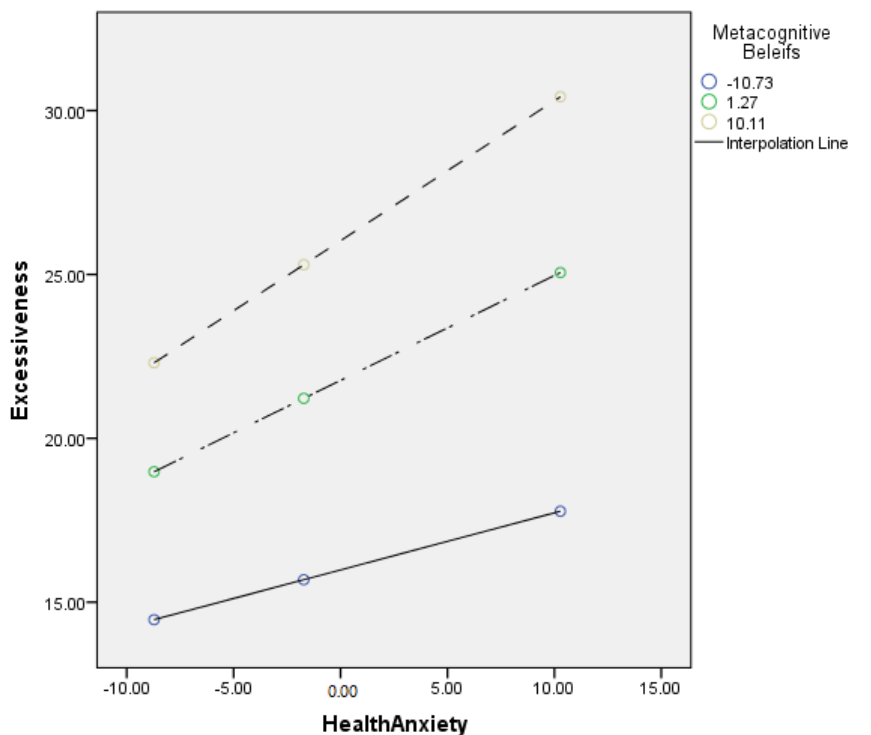
Figure 4. Graphical presentation of moderating role of metacognitive beliefs between health anxiety and excessiveness.